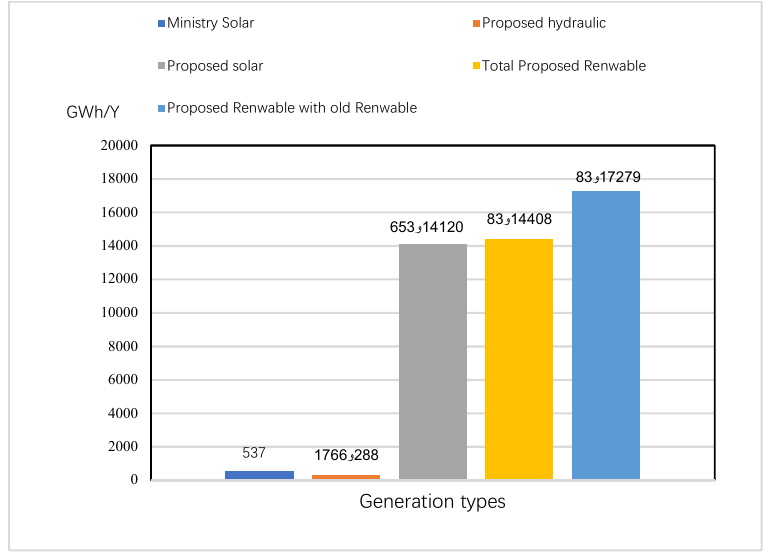
Figure 12. The effectiveness of the proposed hybrid system on the Renewable Egyptian generation systems .